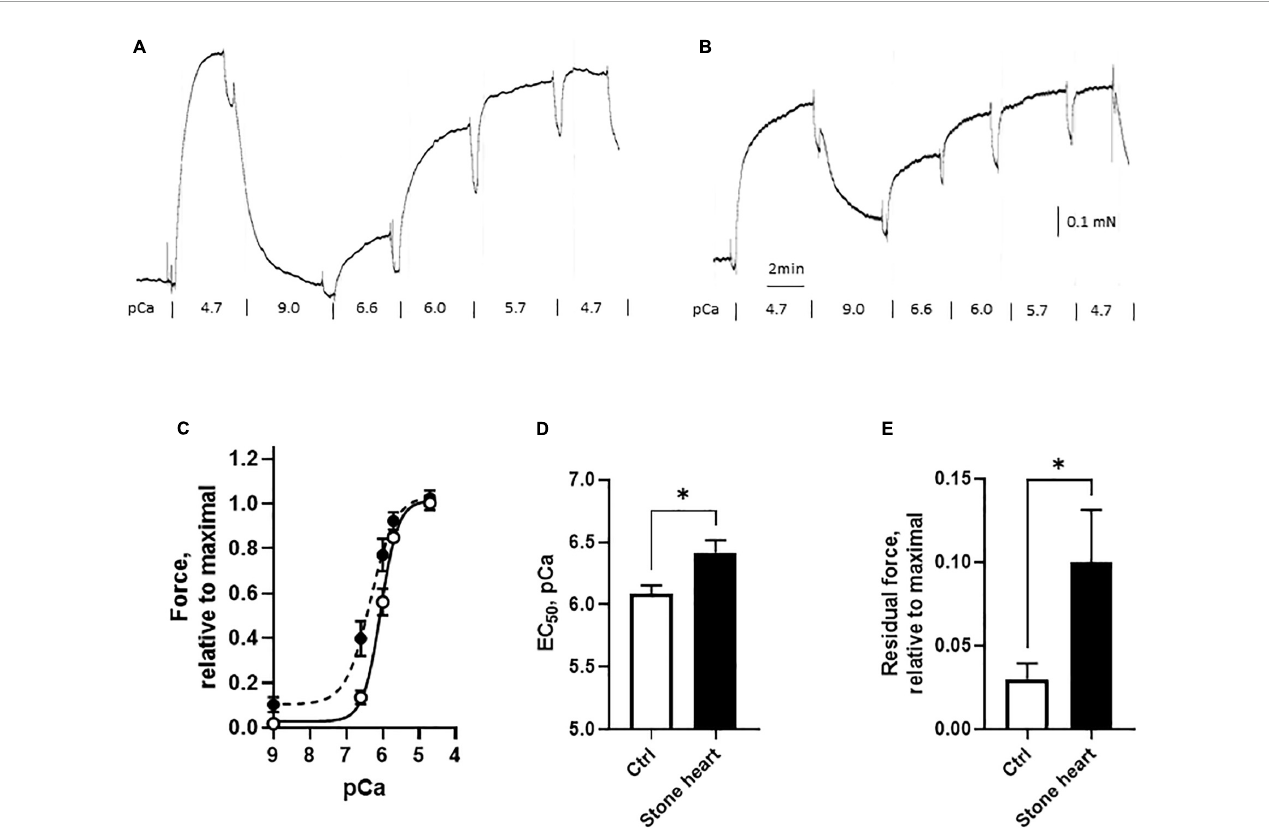
FIGURE5 Calcium sensitivity of skinned cardiac fibers from control (open symbols and bars) and stone hearts (filled symbols and bars). Original traces of contractile responses in a control fiber (A) and a stone heart fiber (B) . Force, relative to initial maximal response vs. pCa (C) . Summarized data showing EC 50 in pCa units (D) and the residual force at pCa = 9.0 (E) . N = 11–12 preparations in each group (from four animals in each group). ∗ p <